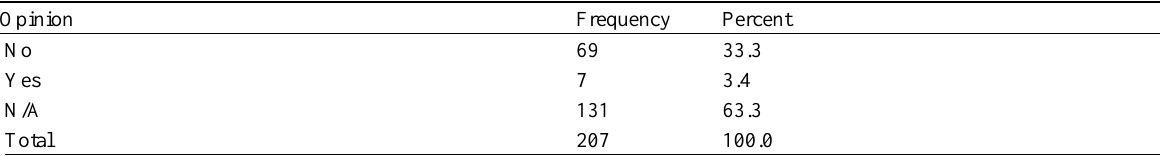
Table 14: Community is involved in Data Collection Procedures